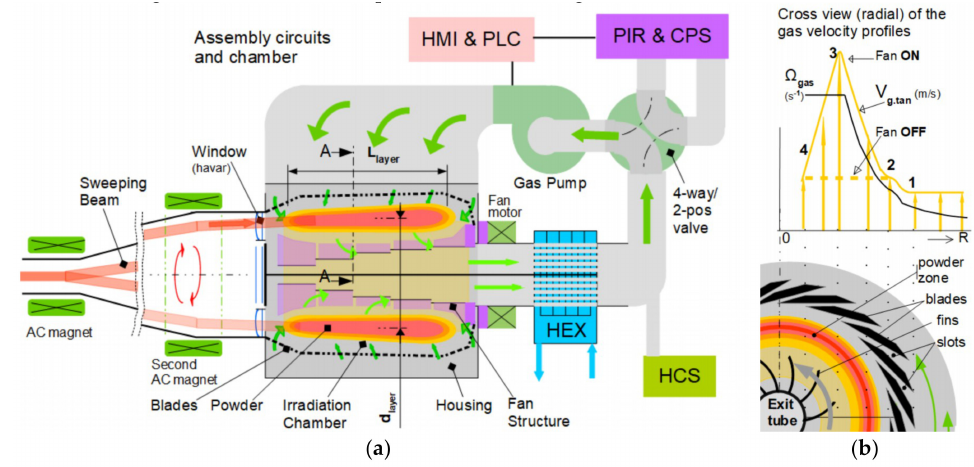
Figure 1. ( a ) Sketch of the gas circulation system setup with the beam guiding system, including a dual AC magnet configuration. The volume region in which the powder accumulates is shown in the irradiation chamber. ( b ) Cross-section (A–A) and diagram of the angular and tangential velocities of the gas rotation vs. radius. The numbers in the diagram indicate the velocity profile changes versus